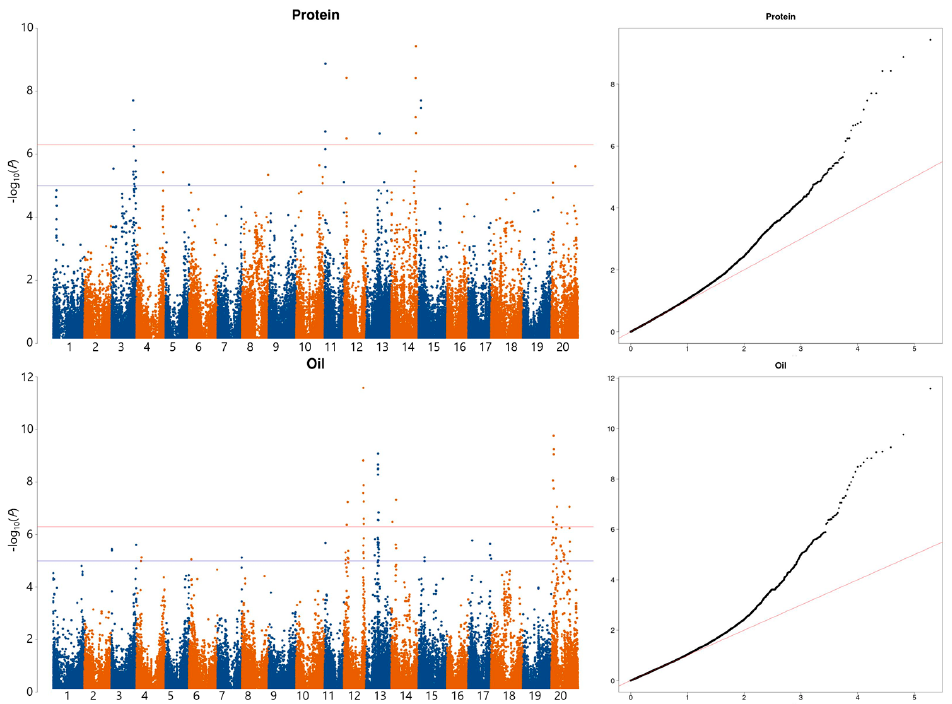
SNPs across seven chromosomes with Ser, twelve SNPs across four chromosomes with Thr, and three SNPs on one chromosome with Val (Figure S1 and Table 4). Only one SNP was detected for each of Iso and Tyr, and no suggestive or significant SNPs were detected for Met. AX-90332294 on chromosome one and AX-90522787 on chromosome three were individually or simultaneously associated with eleven of the seventeen amino acids (all except Arg, Cys, His, Phe, Val, and Met). In addition, the AX-90397199 marker, which was SNP, single-nucleotide polymorphism; Chr, chromosome; Minor, minor allele; Major, major allele; located in almost the same position as the AX-90522787 marker on chromosome three, was MAF, minor allele frequency; + gene model: Glyma.Wm82.a2.v1. associated with Leu and Lys.